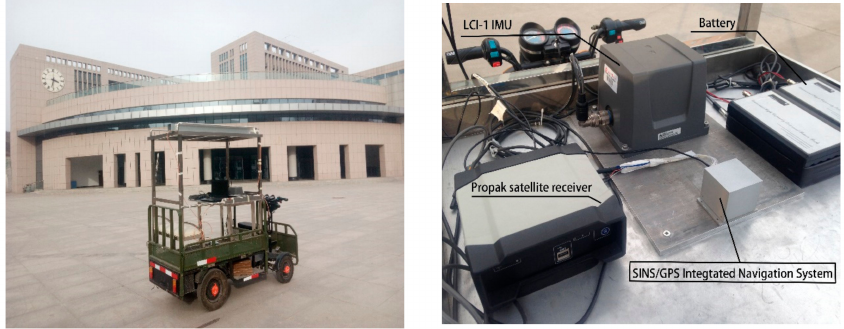
Figure 3. Setup of experimental